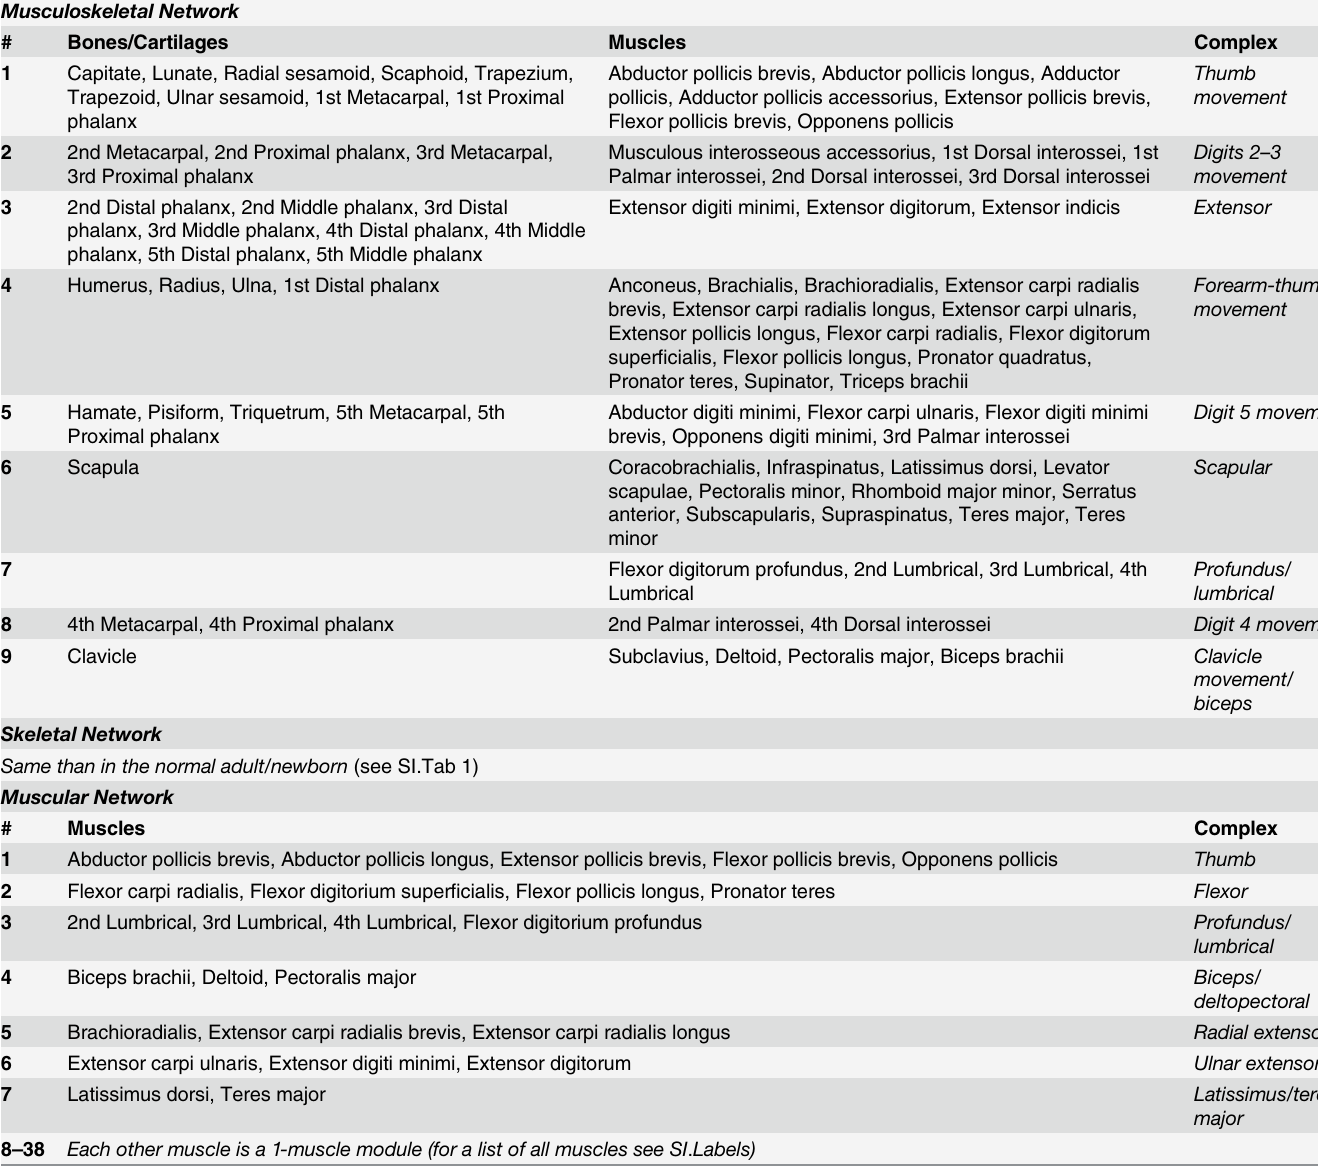
Table 4. Phenotypic modules of the T18 fetus left upper limb identified using